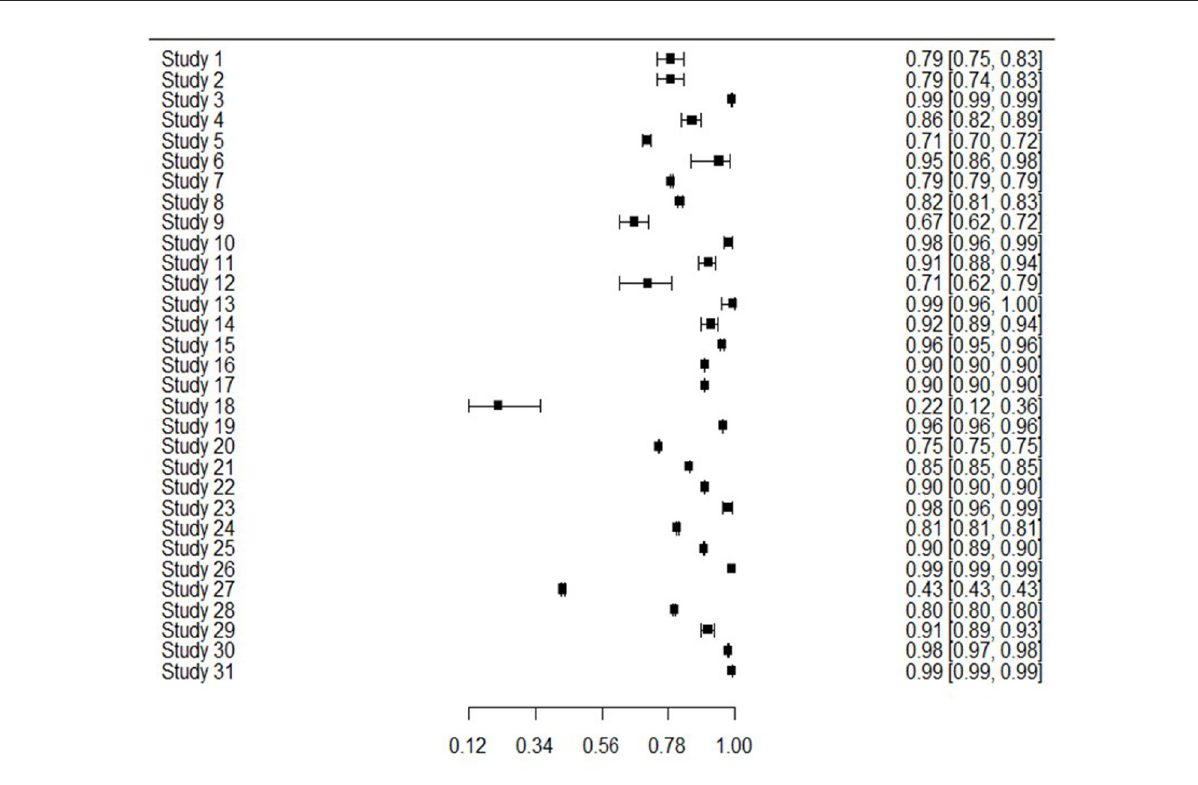
FIGURE3 Forest plot of specificity and CI for all 31 studies.